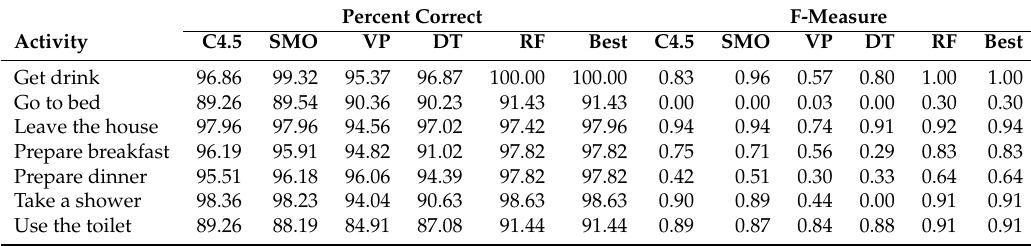
Table 5. Performance of the classic approach when using the mean duration of activities as the lengths of temporal windows ( c = 0). SMO, Sequential Minimal Optimization; VP, Voted Perceptron; DT, Decision